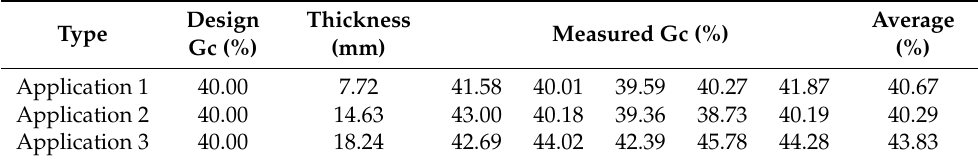
Table 3. Measured Gc of the fabricated hull plate prototypes.